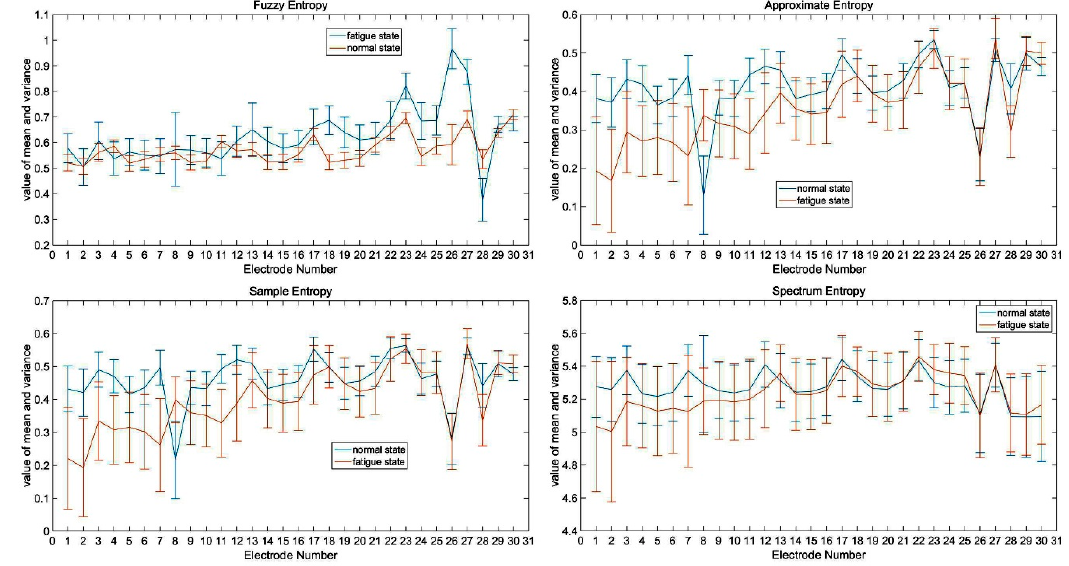
Figure 3. The value of mean and variance in two states with respect to the four types of entropy. Appl. Sci. 2017 , 7 , 150